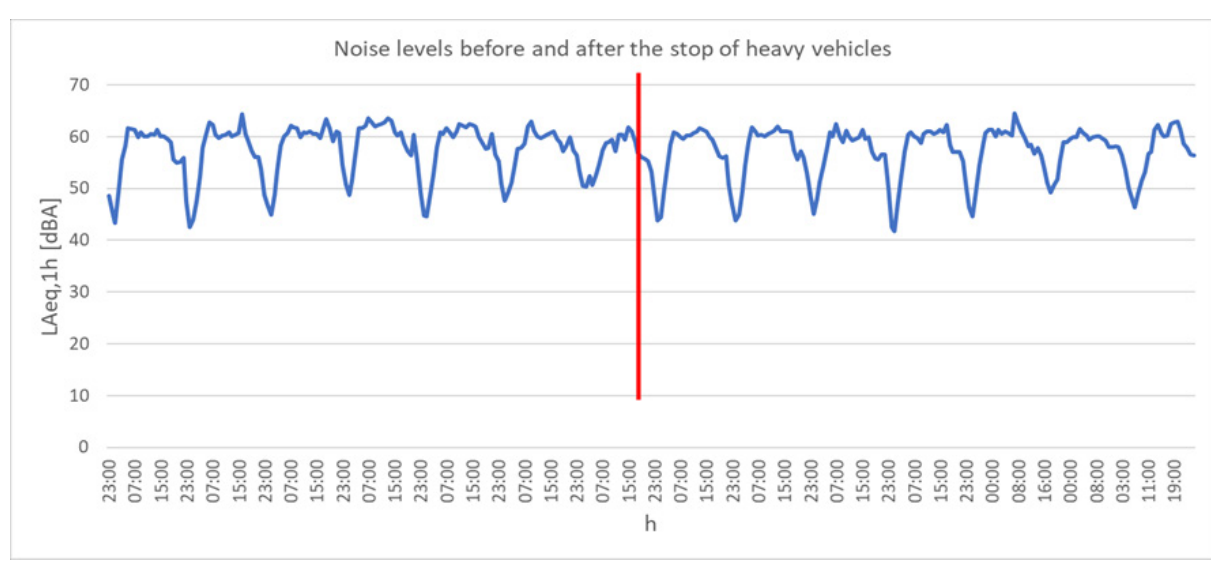
Figure 7: Noise levels recorded by the sensor HC101 before, during and after the laying of the new road surface